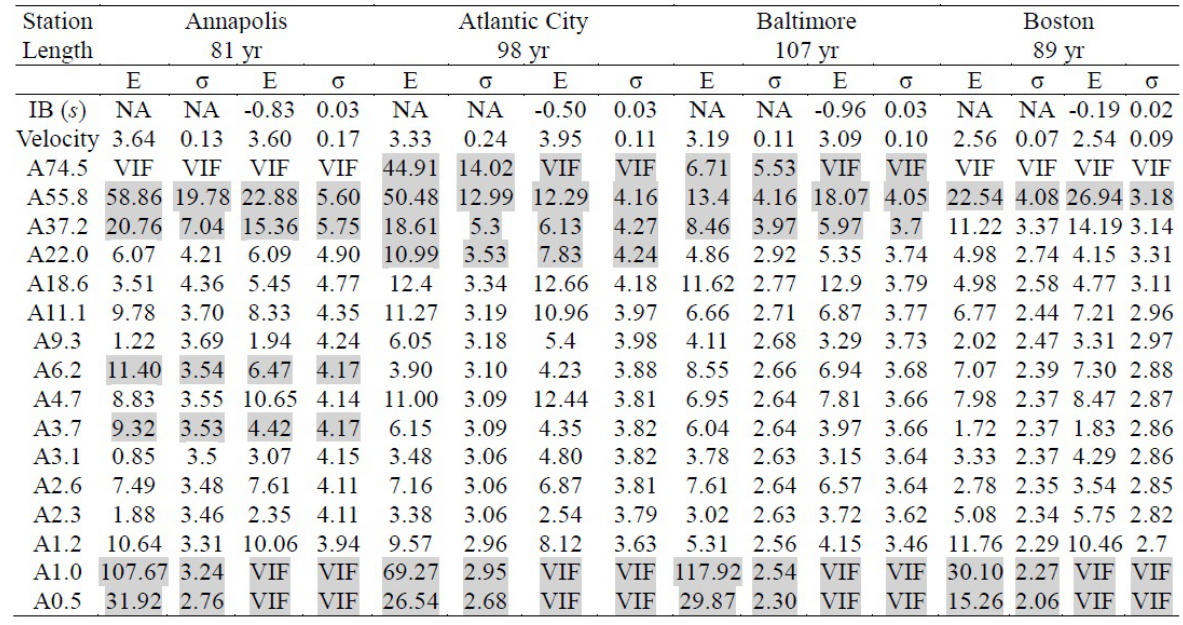
Table 3: The estimates for the two model parameters (trends and the amplitudes of the periodicities calculated from their estimated com- ponents) and their statistics for all the tide gauge stations are listed. The amplitudes of the periodicities are in mm, which are followed by their standard deviations. Station velocity estimates (trends) are in mm/yr. The first set of estimates were calculated without the parametrization of the IB effect in the model. The highlighted amplitudes and the trend estimates are all impacted by the inclusion of the atmospheric pressure in the model if the amplitude changes were larger than 4 mm. No estimates are available for the blank cells. Because of their high VIFs, the corresponding periodicities were not included in the